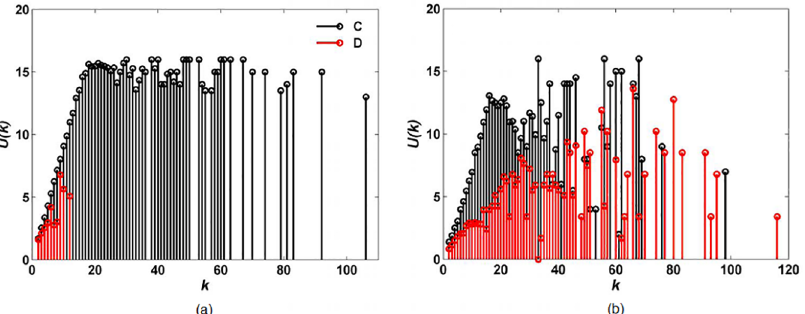
Fig 4. Average payoff U ( k ) of a player of degree k in the stationary regime of evolutionary dynamics under (a) random interaction and (b) high-degree preferenceinteraction. Cooperator is denotedby C with black and defector by D with red. Defect temptation and upper-bound are set to b = 1.7 and W = 16,